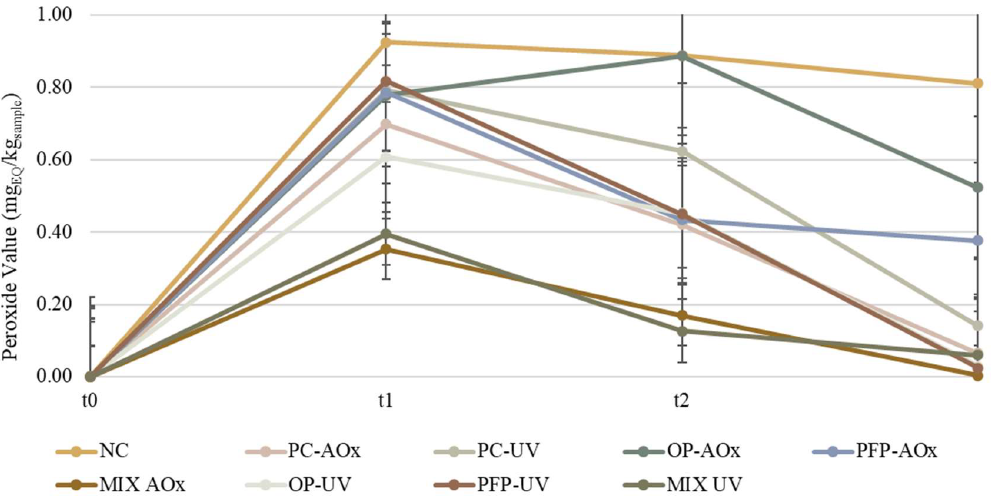
Figure 7. Variation in the peroxide value throughout the study period for the produced formula- tions. The analysis was performed for three study times: t 0 —week of production; t 1 —two weeks after production; t 2 —four weeks after production. NC: negative control; PC-AOx: positive antioxidant control; OP-AOx: onion peel extract antioxidant sample; PFP-AOx: passion fruit peel extract antioxidant sample; Mix-AOx: mixture of antioxidant control and OP and PFP extract; PC-UV: positive UV filter control; OP-UV: onion peel extract UV filter sample; PFP-UV: passion fruit peel ex- tract UV filter sample; Mix-UV: mixture of UV filter control and OP and PFP extract.